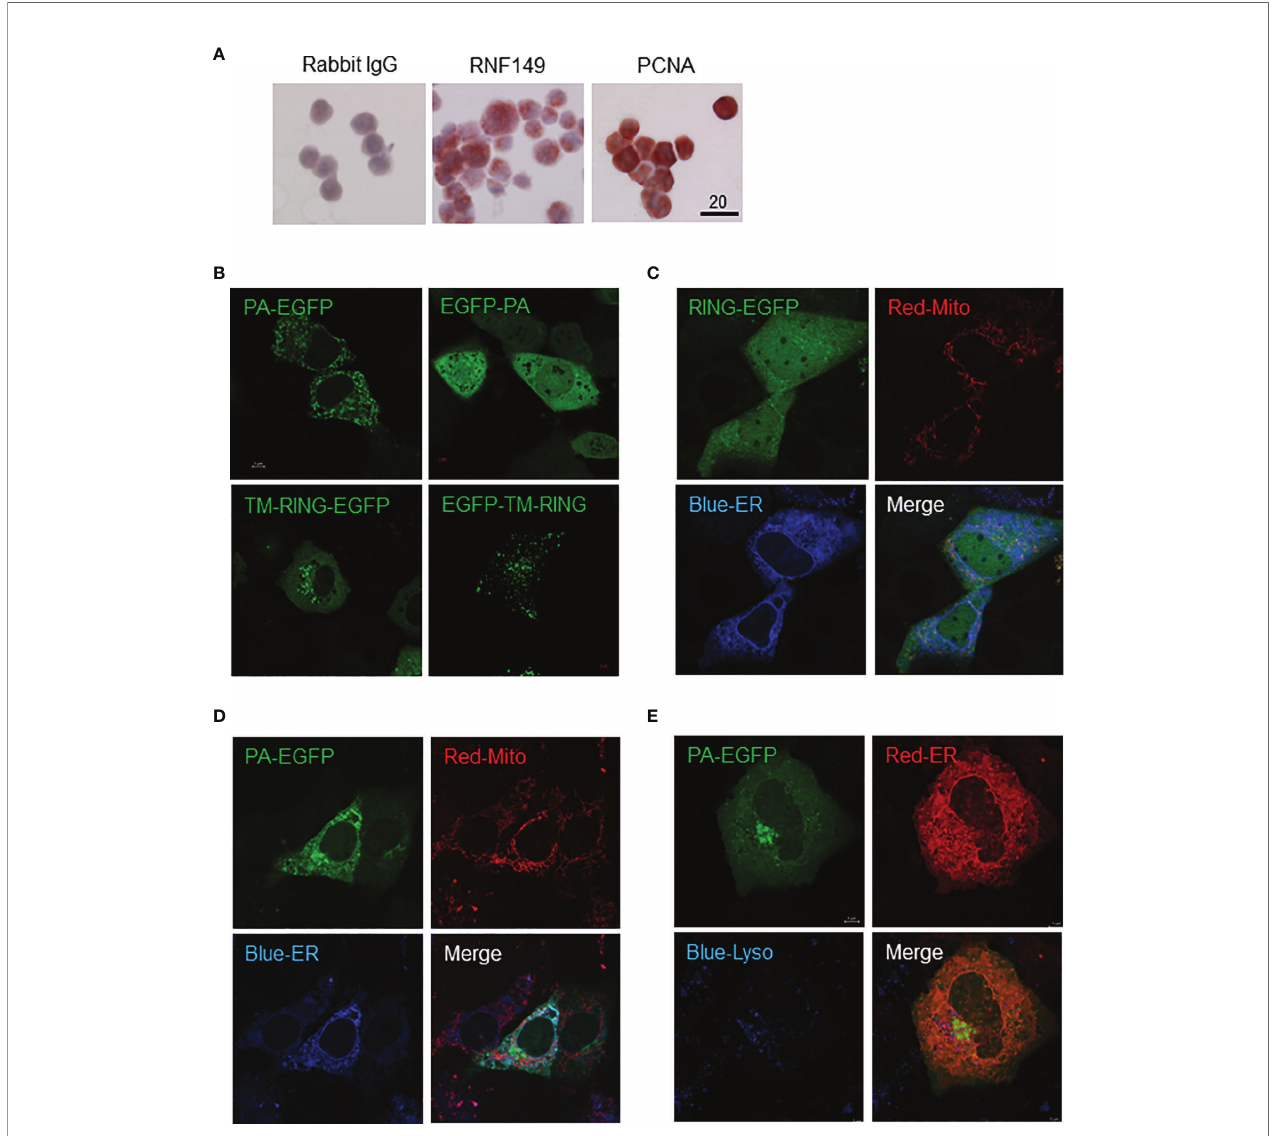
FIGURE 7 | C18-4 cells as a potential model for studying RNF149 function. (A) Colorimetric analysis of C18-4 cells positively expressing RNF149 and PCNA. 20 m m scale shown. Representative cells shown. (B) Single transfection of EGFP-tagged RNF149 isoforms. (C) RNF149 is co-localized with ER by PA domain. RING-EGFP vector co-transfected with mitochondria marker (red) and ER marker (blue). (D) PA-EGFP vector co-transfected with mitochondria marker (red) and ER marker (blue). Both co-transfections were performed using Lipofectamine ™ 3000 (Invitrogen) 24 hours before microscopic observation (according to the manufacturer ’ s protocol). (E) RNF149 is co-localized with ER by PA domain but not the lysosome. PA-type RNF149 isoform is co-transfected with ER marker (red) and lysosome marker [blue; LysoTracker Blue DND-22 (Life Technologies)]. Representative images